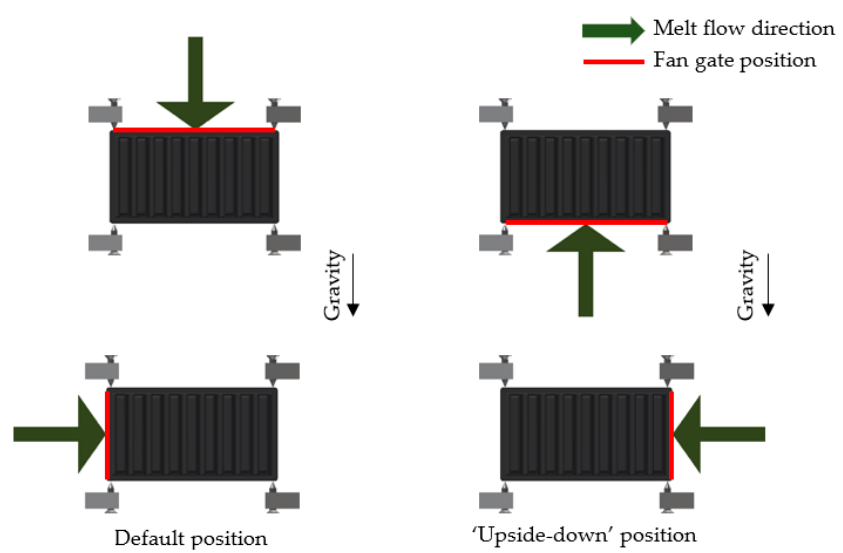
Figure 6. Orientation of the melt entry for both measured heat sinks in two different measurement positions, ( left )—default position, ( right )—“upside-down”. Melt entrance along the red edge, melt flow in the direction of the green arrow.